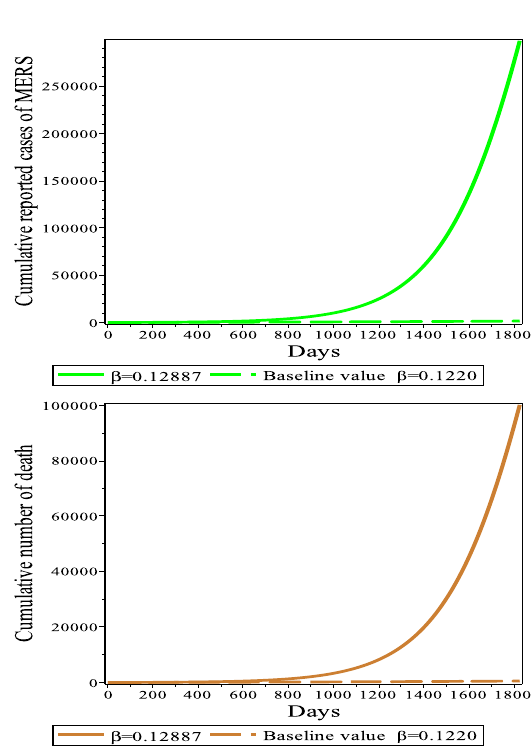
Fig. 10: Simulation results for the cumulative reported cases of MERS (T) and the cumulative number of deaths (B). Parameter values used are β = 0 . 12200 – dashed lower curves; and β = 0 . 12887 – solid